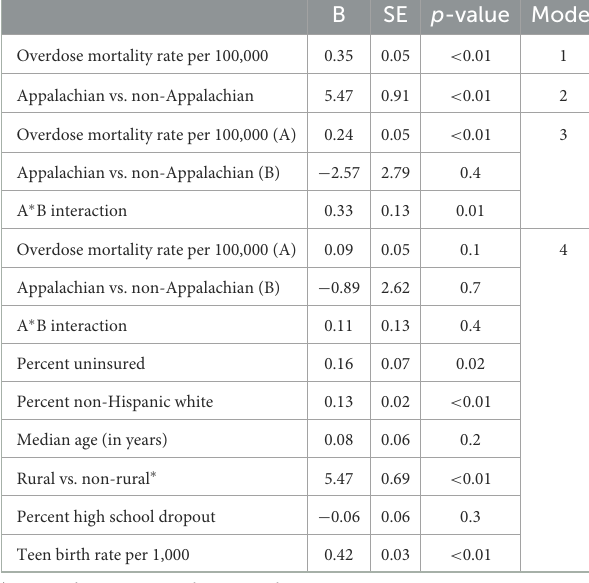
TABLE 2 Results of bivariate and multivariable linear regression models examining county-level associations with grandparents as primary caregivers of